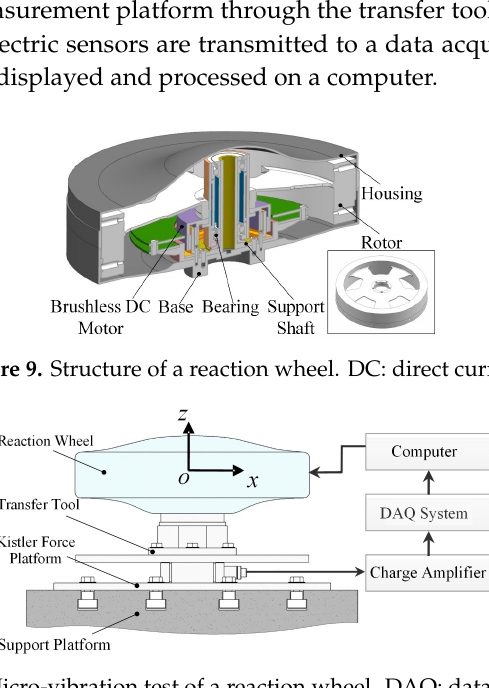
Figure 10. Micro-vibration test of a reaction wheel. DAQ: data acquisition.